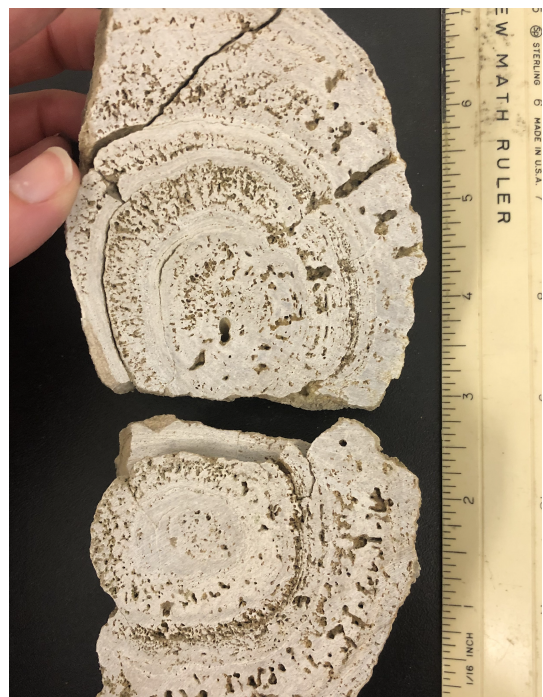
Figure 9. Hand specimen of a Barstow Formation tufa sample that is large enough to slab and share as a secondary LAcarb reference